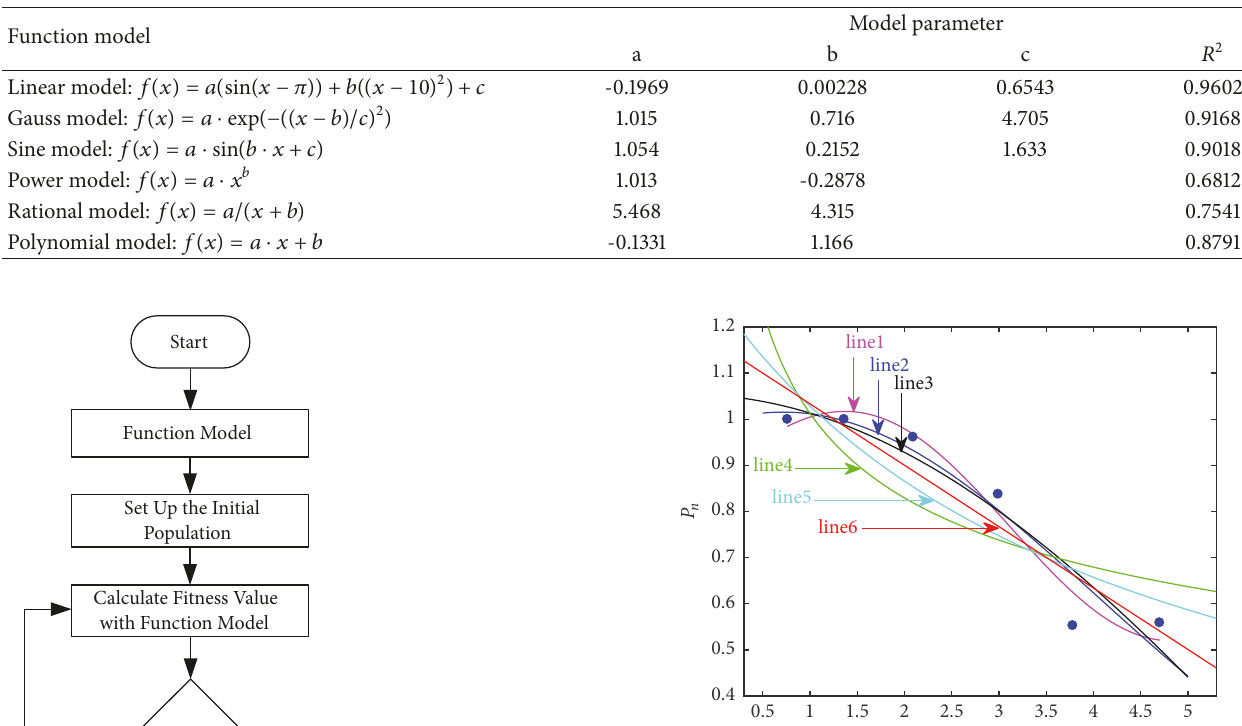
Table 2: The function model fits the data in Table 1.